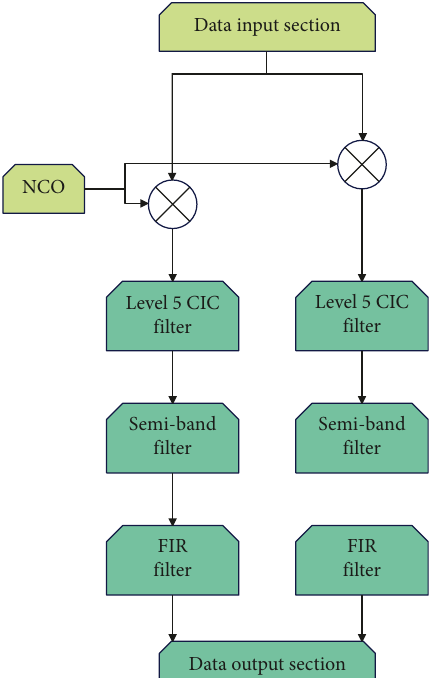
Figure 1: Down-conversion structure